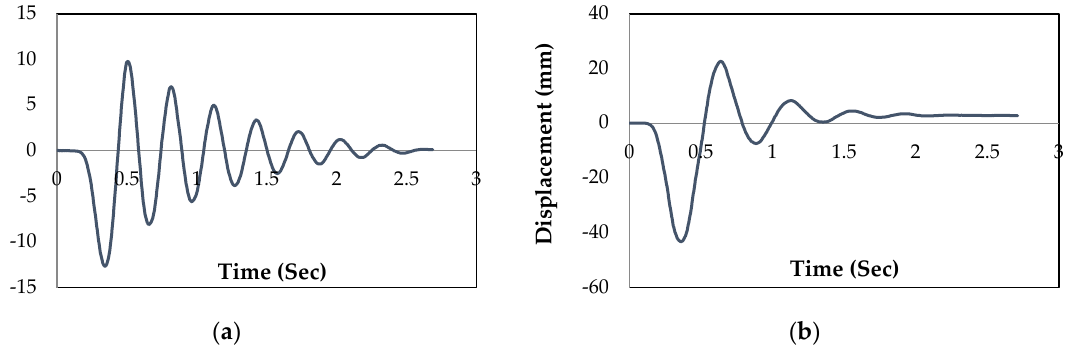
Figure 7. The free vibration displacement response of: ( a ) the fixed-base structure, and ( b ) the soil-pile-supported model ( L = 15 D and S = 3 D ).